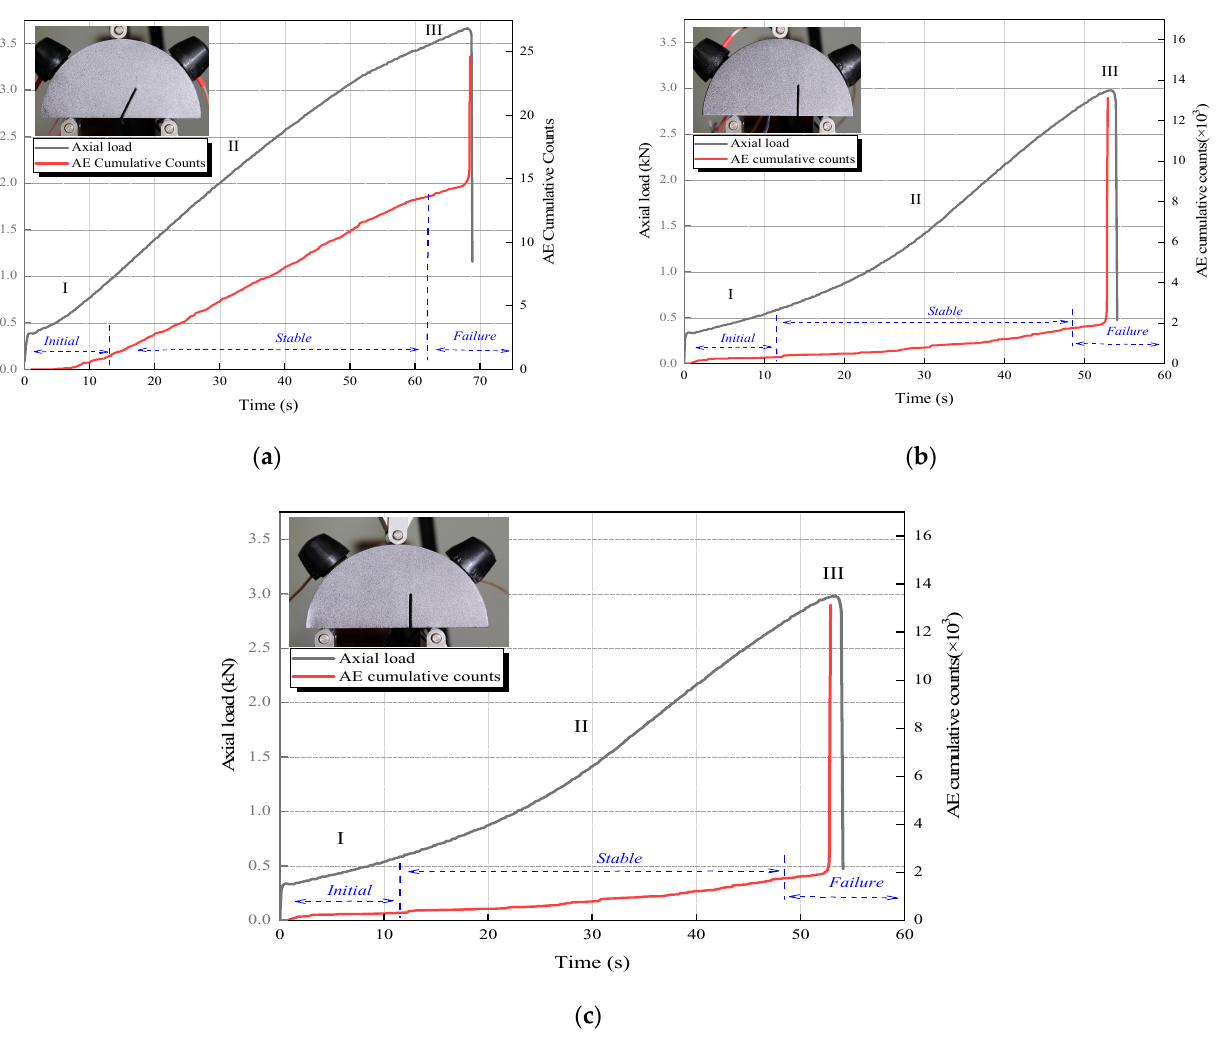
Figure 5. Evolution of axial load and AE counts ( a ) ANSCB-I; ( b ) ANSCB-II; ( c ) ANSCB-III. Stage I: The loading curve and AE cumulative counts show a gentle trend in this stage. The voids in the compression zone inside the specimen are closed and only a small number of acoustic emission signals are generated.